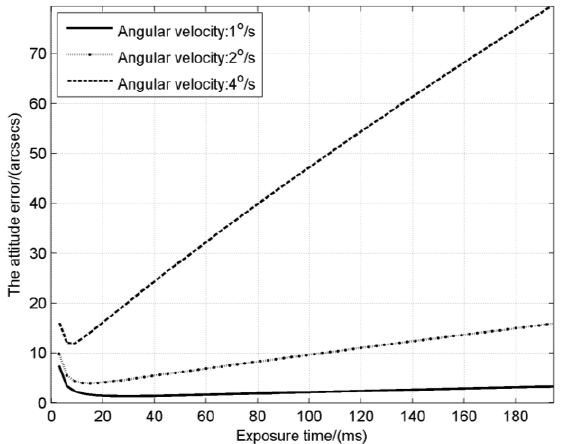
Figure 7. The attitude error with different exposure times.